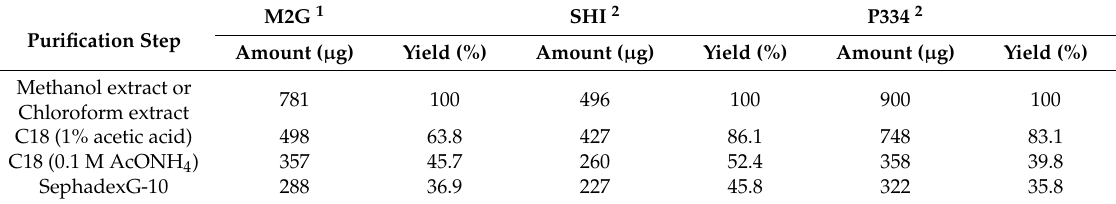
Table 1. Purification yields of mycosporine-like amino acids (MAAs).